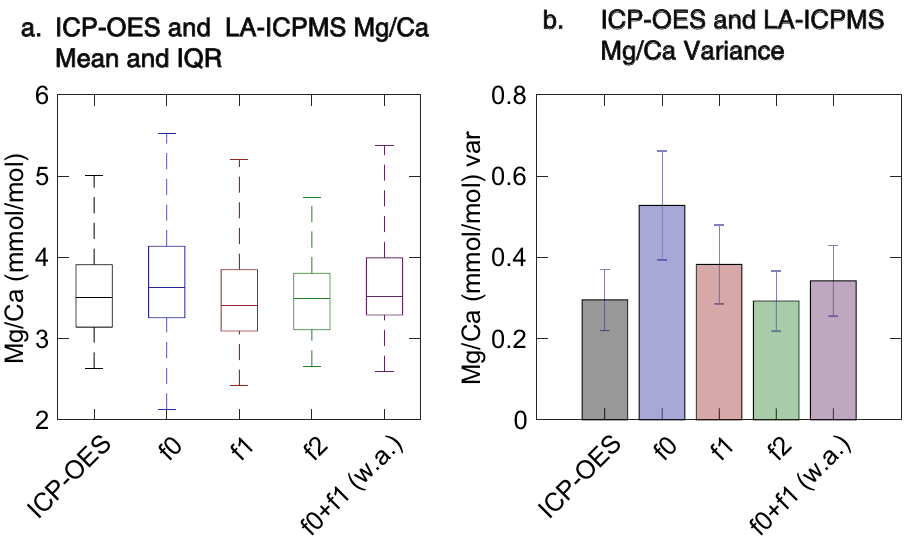
Figure 6. Comparison of same-individual Mg/Ca from ICP-OES and LA-ICPMS. ( a ) population mean, interquartile range, and range of Mg/Ca values from ICP-OES and LA-ICPMS analysis on the same individuals. LA-ICPMS results are shown separated by chamber (f0, f1, f2) and using the 55% f0 + 45% f1 weighted average (w.a.) that produces the maximal correlation. No statistical difference is observed in the population means (Student’s t-test, p > 0.05, N = 32). ( b ) population variance for ICP-OES and LA-ICPMS Mg/Ca, also separated by chamber and with the 55% f0 + 45% f1 weighted average. Error bars show the standard error of the variance. None of the variances differ significantly (one-sided f-test, p >